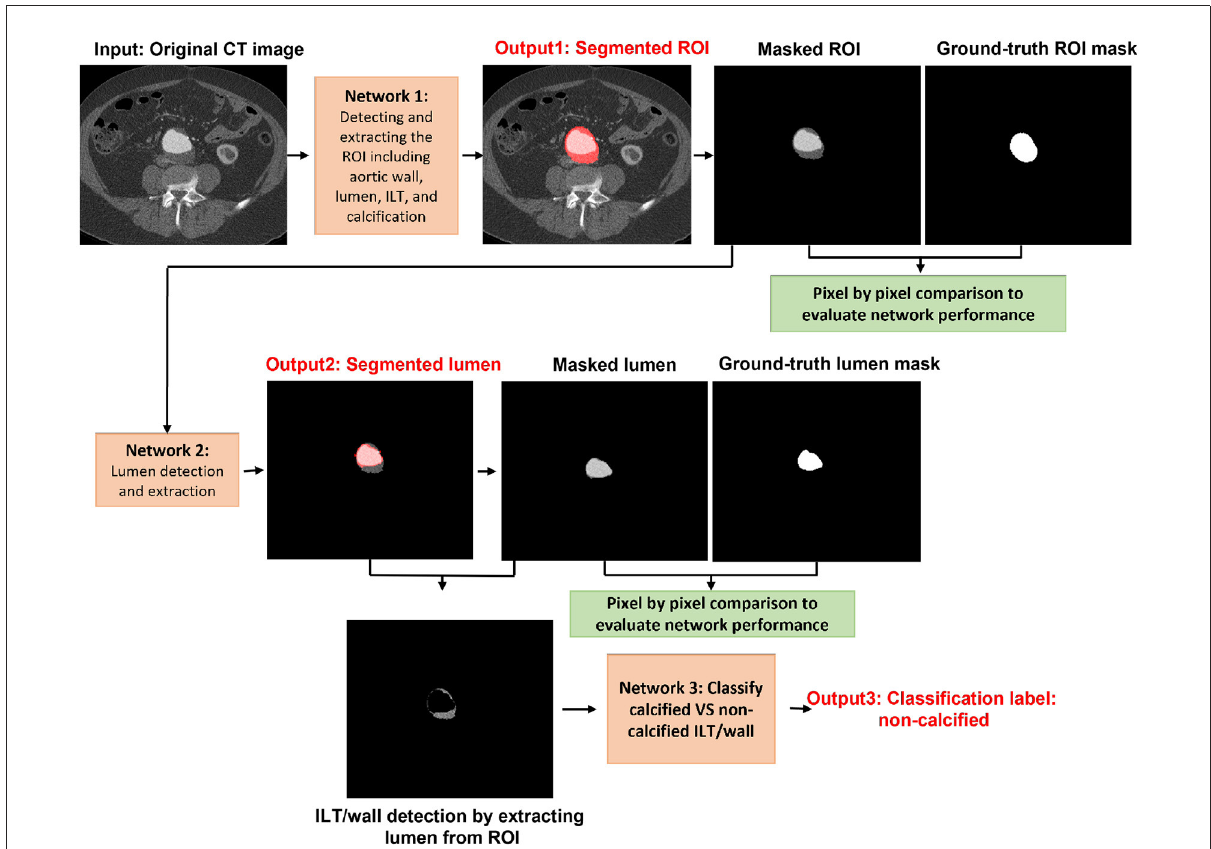
FIGURE3 Visual representation of each network output for segmenting the ROI including the abdominal aorta, lumen, ILT, and wall. Calcification accumulation in ILT and wall was determined in the final